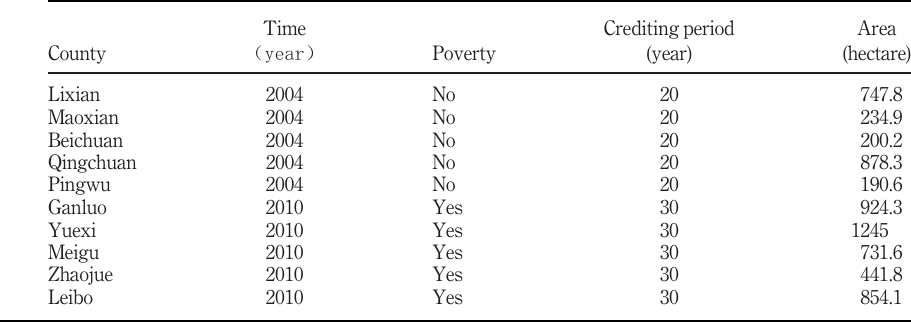
Table 1. Basic situation of Sichuan